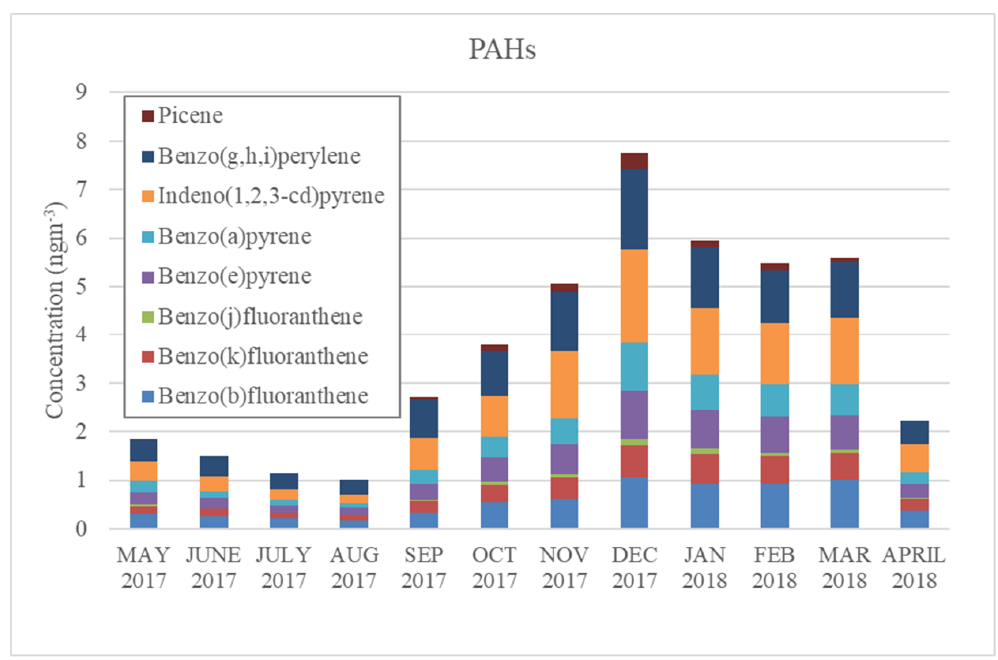
Figure 4. Monthly concentrations of polycyclic aromatic hydrocarbons (PAHs) in Yangon, Myanmar.